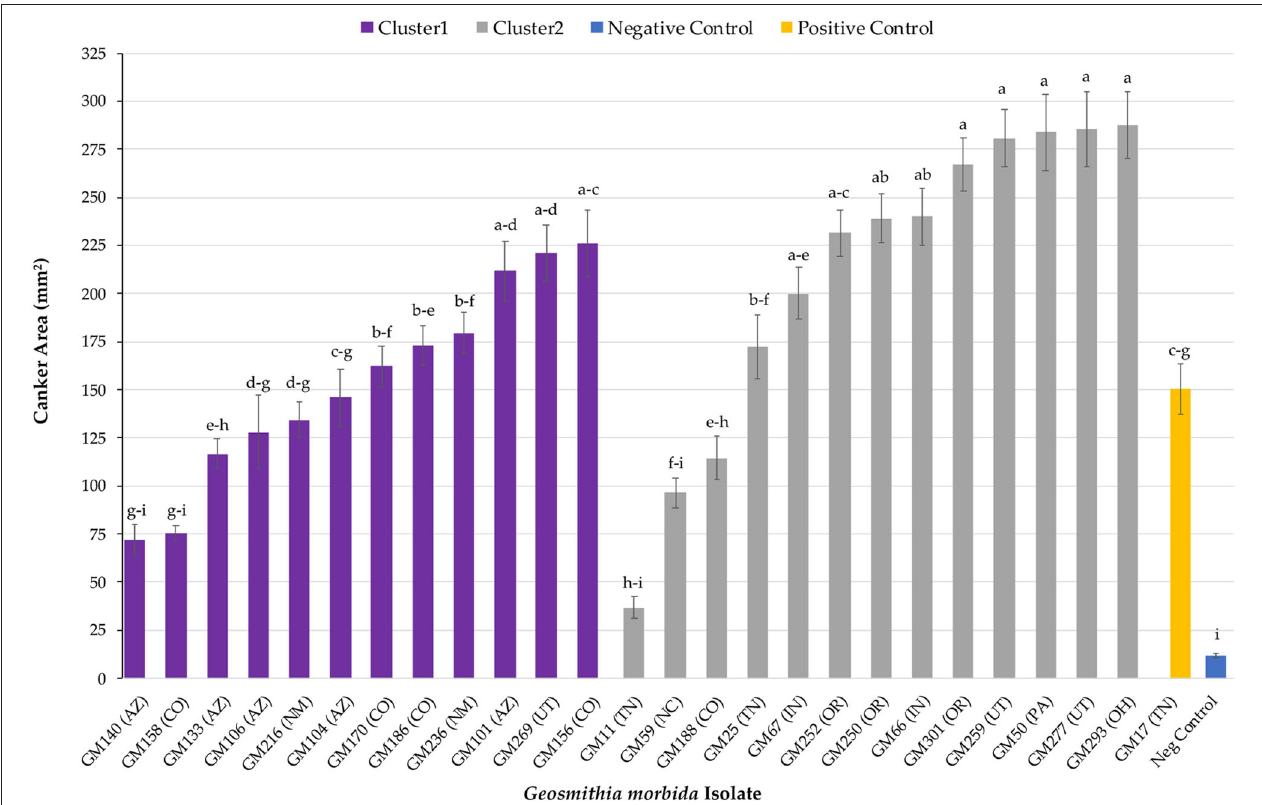
FIGURE 2 | Mean canker area observed across all G. morbida isolates. For each isolate, treatment mean separations were made using least square mean estimates calculated from rank-transformed canker areas and differ significantly ( P < 0.05; Tukey’s honestly significant difference) when indicated with different letters. Mean canker areas and standard errors depicted here reflect non-transformed data measured across both assayed trees.